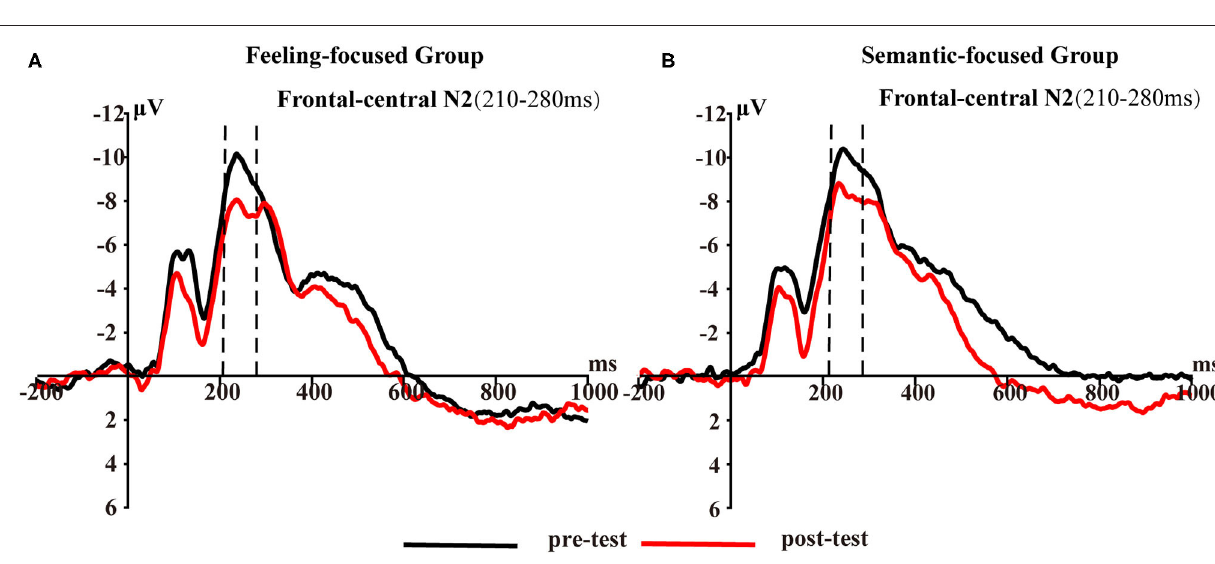
4, we separated the two groups of data and conducted Valence × Test × Region analyses for each